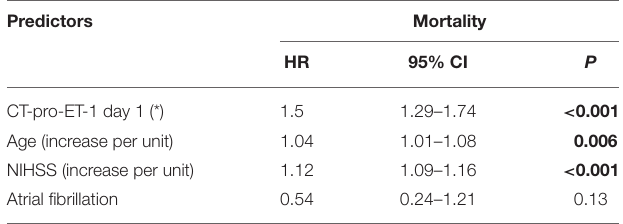
TABLE 2 | Multivariate analysis: cox proportional hazards model for survival after 90